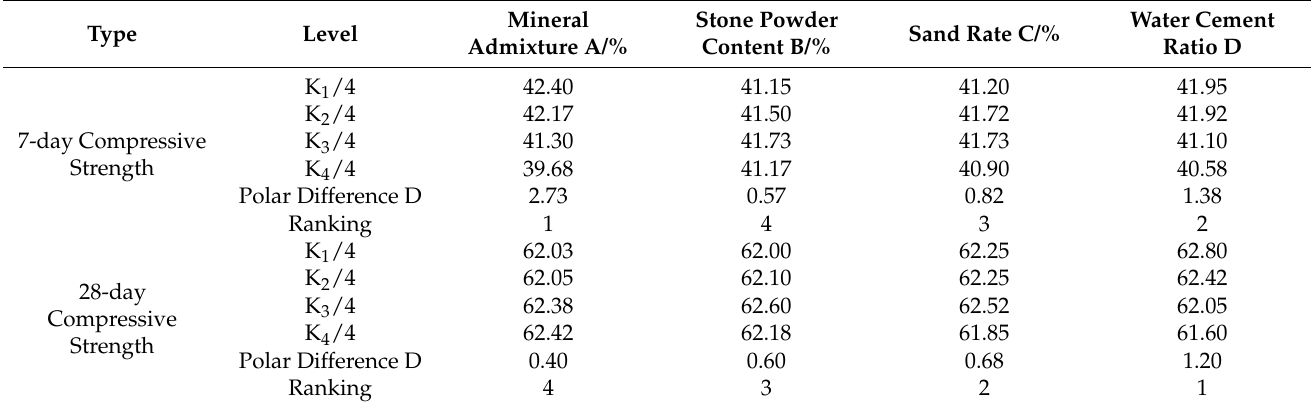
Table 8. Table of extreme difference analysis of compressive strength